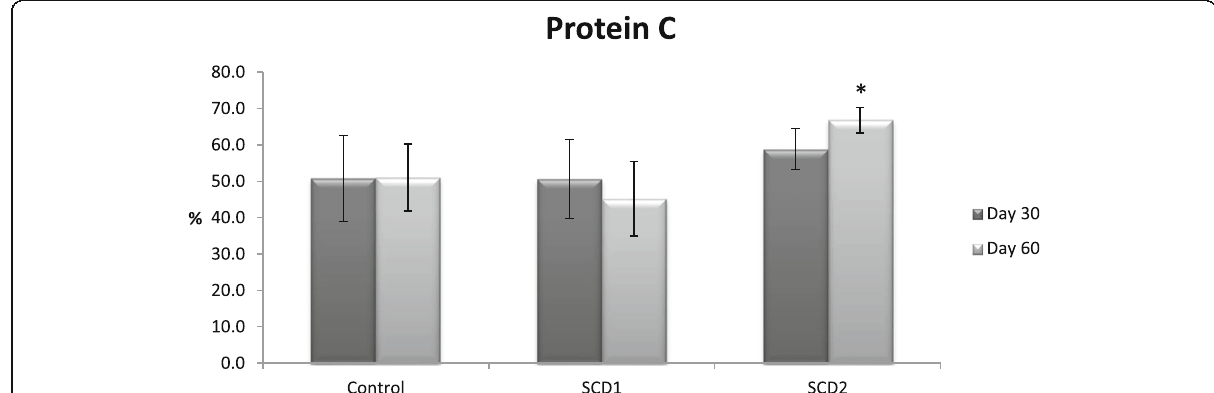
Fig. 1 Effects of Syzygium cumini and control on Protein C in rabbits. Data is represented as Average values ± SEM, where n = 10; Two different doses of S. cumini were used as follows: SCD1:150 mg/kg; SCD2: 500 mg/kg, * p ≤ 0.05 significant as compared to